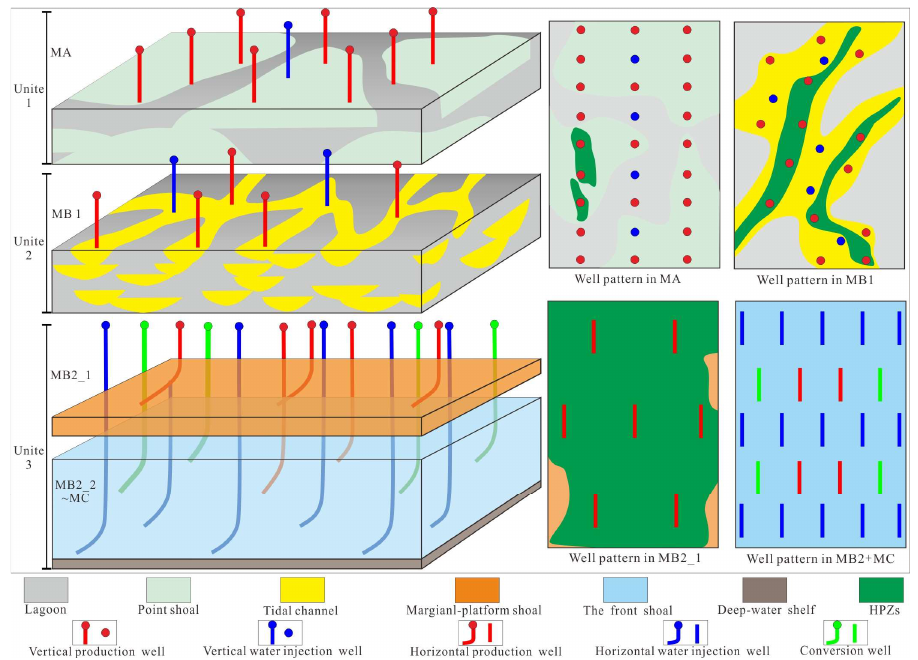
Figure 12. Balanced development model in the Mishrif Formation in X Oilfield.